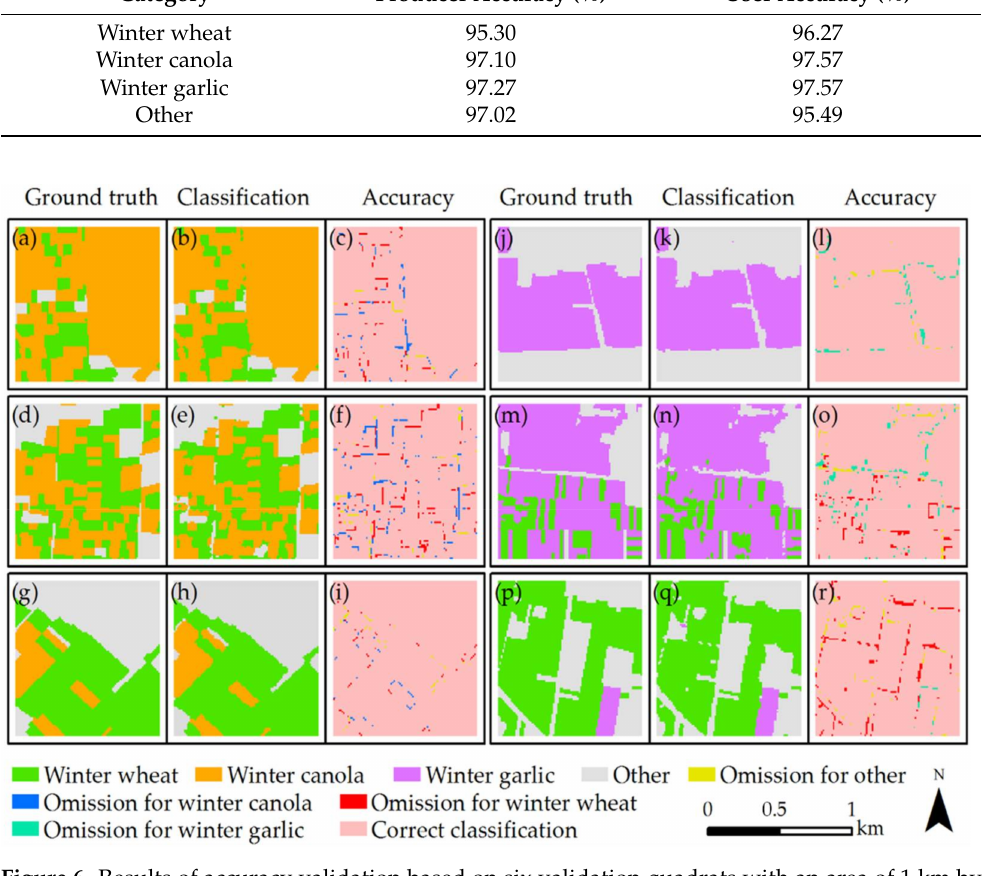
Figure 6. Results of accuracy validation based on six validation quadrats with an area of 1 km by 1 km. ( a , d , g , j , m , p ) are the ground truth quadrats. ( b , e , h , k , n , q ) are the classification results for each quadrat. ( c , f , i , l , o , r ) are accuracy validation